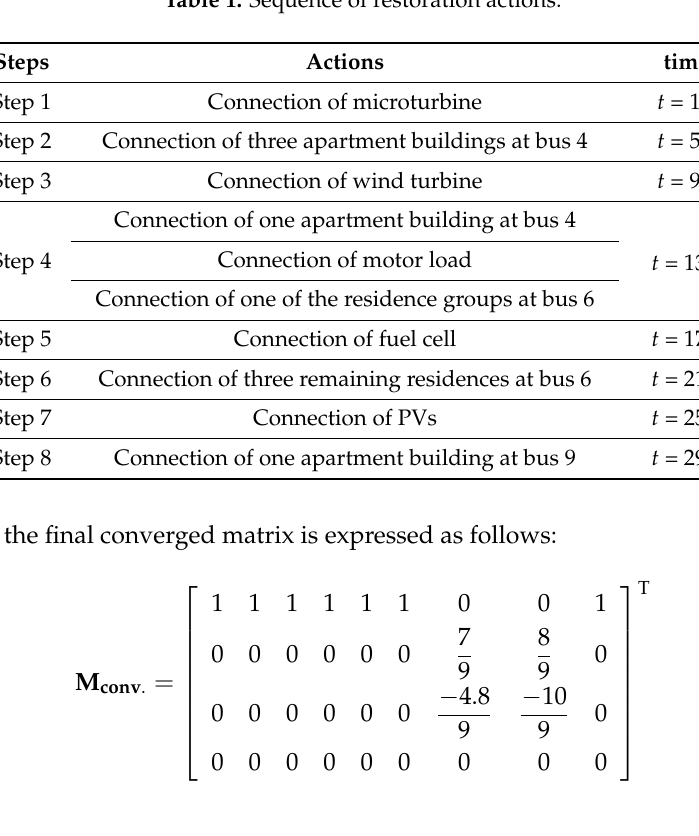
Table 1. Sequence of restoration